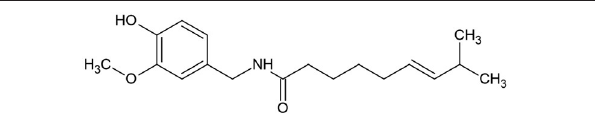
FIGURE 2 | Capsaicin chemical